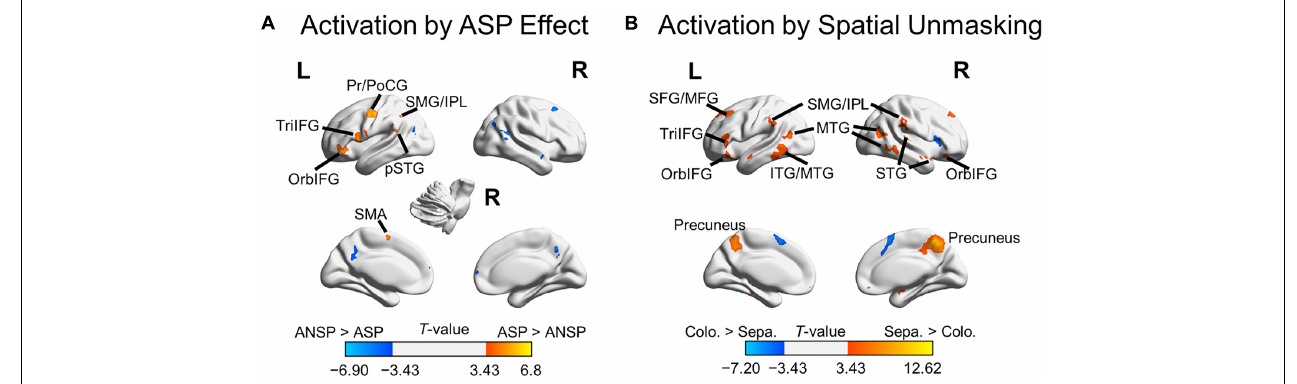
FIGURE 3 | Areas of the brain activated by the ASP effect and spatial unmasking effect. (A) Clusters activated by the “ASP > ANSP” contrast (i.e., the ASP effect, the warm color) and by the “ANSP > ASP” contrast (the cold color). (B) Clusters activated by the “perceived separation > perceived co-location” contrast (i.e., spatial unmasking effect, the warm color) and by the “perceived co-location > perceived separation” contrast (the cold color). ITG, inferior temporal gyrus; MTG, middle temporal gyrus; PrCG, precentral gyrus; PoCG, postcentral gyrus; SFG, superior frontal gyrus; SMA, supplementary motor area; STG, superior temporal gyrus; pSTG, posterior STG. L, left; R, right.